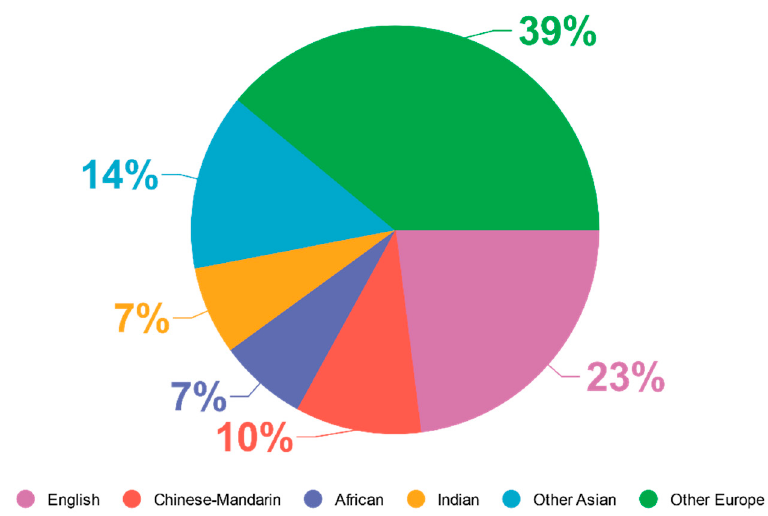
Figure 1. The languages investigated by the selected papers.